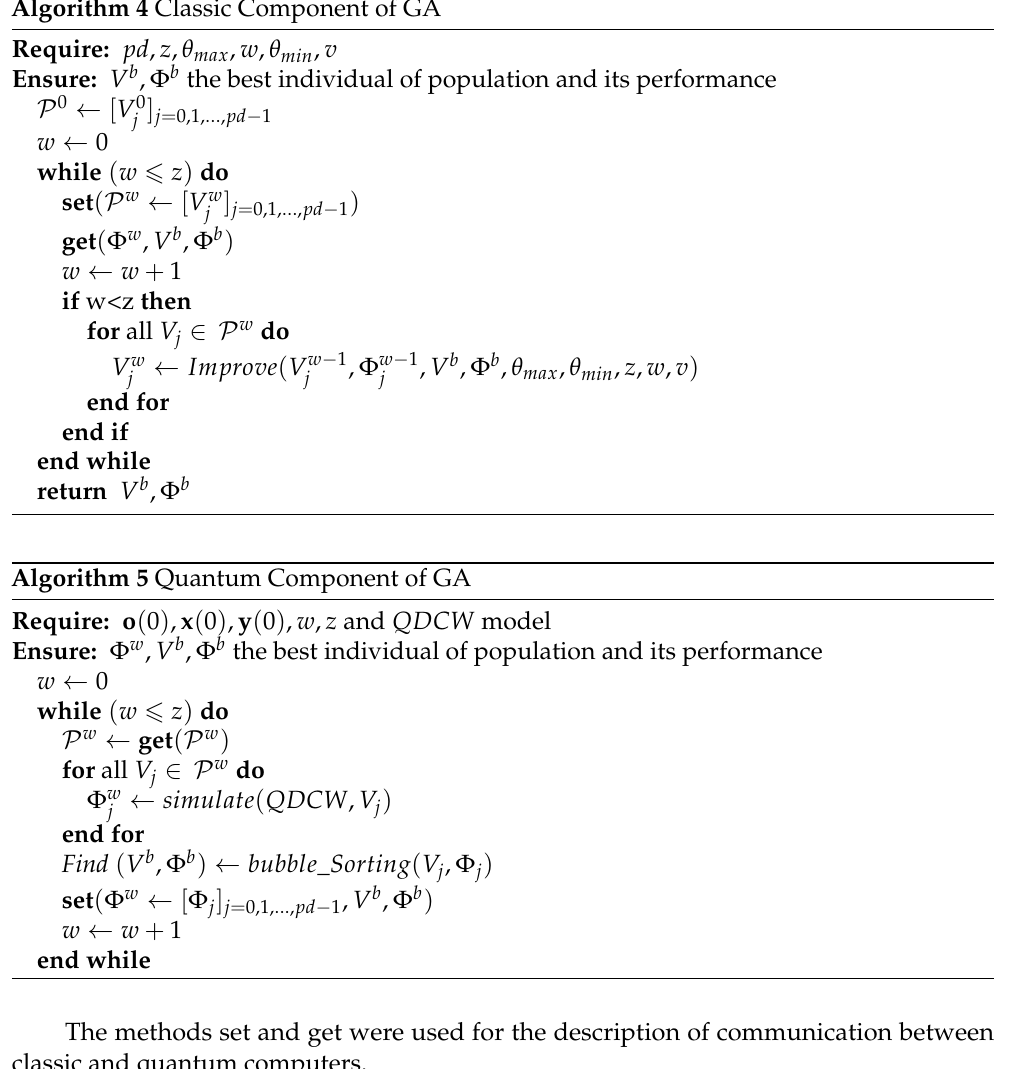
Algorithm 4 Classic Component of GA